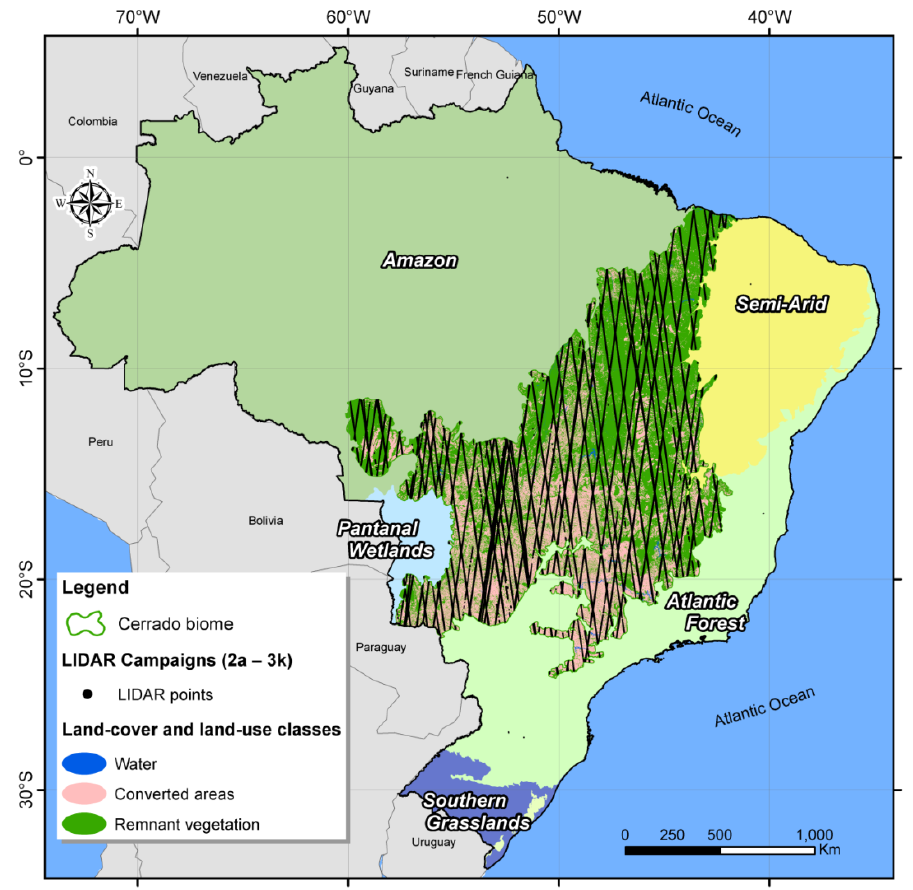
Figure 2. GLAS LIDAR data points over the Cerrado biome (shown relative to